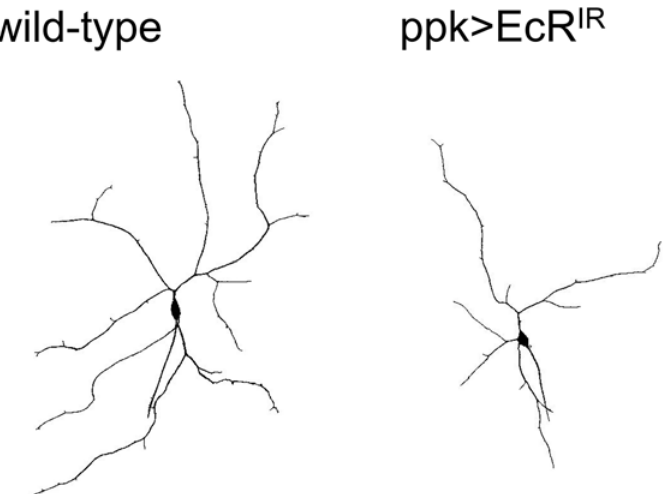
Fig 5. Nociceptor neuron dendritic reduction in EcR RNAi larvae. Confocal visualization of live third instar larvae expressing eGFP in nociceptor neurons ( ppk-eGFP ; left) reveals reduction in dendritic length and branch number when EcR is suppressed via RNAi driven by ppkGal4 (right). The ddaC neurons depicted represent the average for overall dendritic length, and more than 70% of all neurons analyzed (n = 20 for wild- type and n = 19 for EcR-RNAi) showed a length that was within one standard deviation from the lengths of these representative neurons.